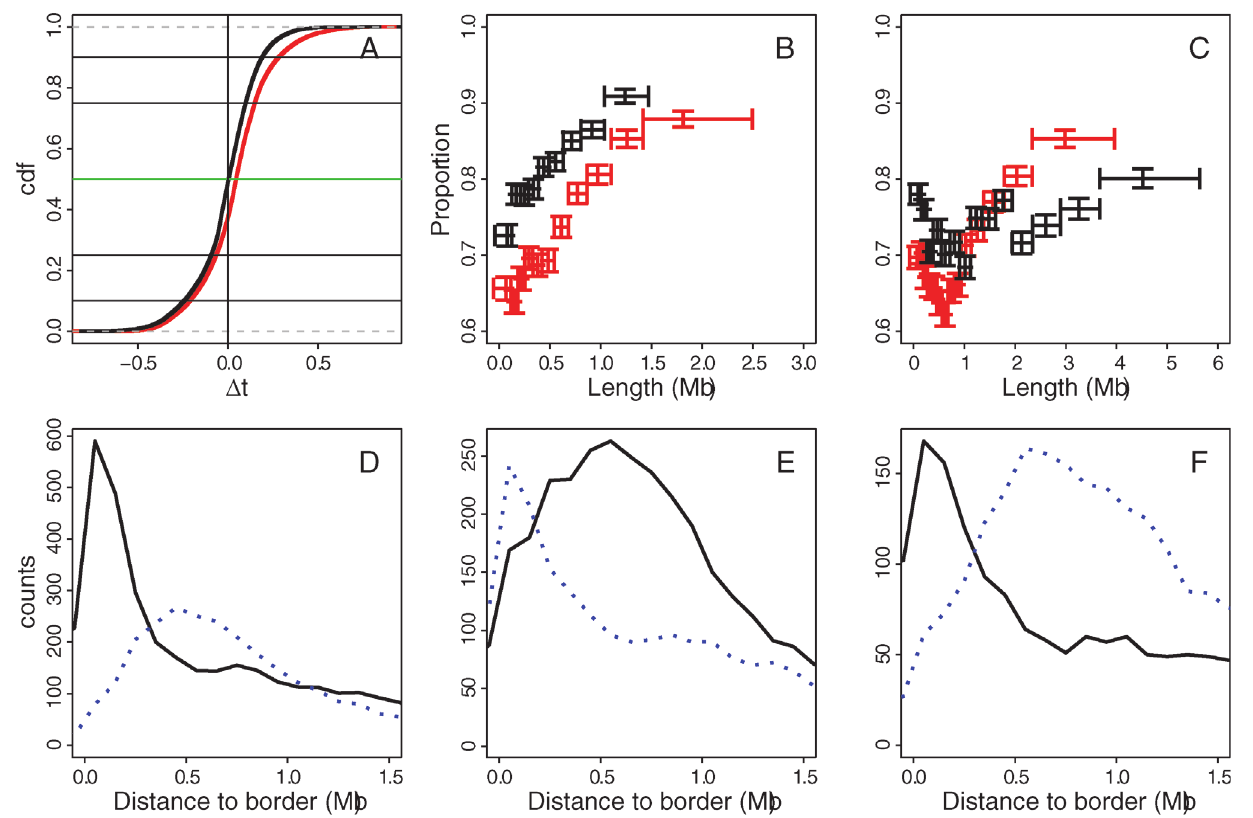
Figure 6. (A) Cumulative distribution function (cdf) of MRT difference Δ t between two cell lines: Δ t = MRT(Nhdfad) − MRT(H1hesc) (red) and Δ t = MRT(Nhdfad) − MRT(K562) (black). Horizontal lines mark from bottom to top the first decile, first quartile, median, last quartile and last decile, respectively. (B) Proportion of 100 kb windows in C1+C2 blocks that have a conserved MRT ( j Δ t j < 0.2) with respect to block length: H1hesc blocks with MRT compared to Nhdfad (red) and K562 blocks with MRT compared to Nhdfad timing (black). (C) Same as (B) for C3+C4 blocks. (D) Histogram of distances to H1hesc U-domain borders for loci that have a Δ t = MRT(Nhdfad) − MRT(H1hesc) > 0.2 (line) and < − 0.2 (dots). (E) Histogram of distances to Nhdfad U-domain borders for loci that have a Δ t = MRT(Nhdfad) − MRT(H1hesc) > 0.2 (line) and < − 0.2 (dots). (F) Histogram of distances to K562 U-domain borders for loci that have a Δ t = MRT(Nhdfad) − MRT(K562) > 0.2 (line) and < − 0.2